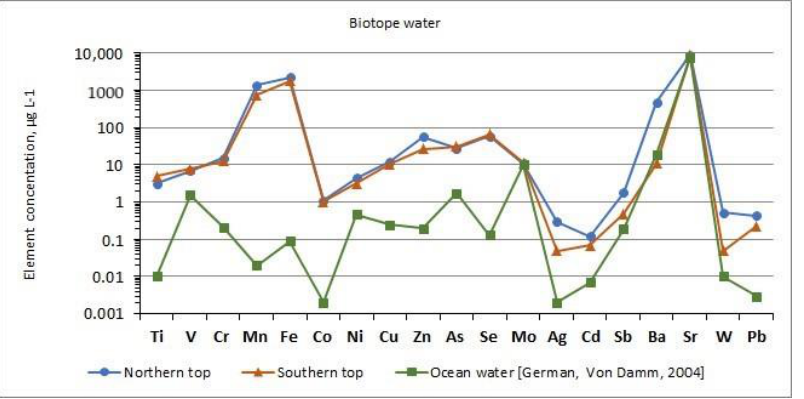
Figure 12. Trace element concentrations in the biotope water at the northern and southern tops of the Piip Volcano compared to the ocean water